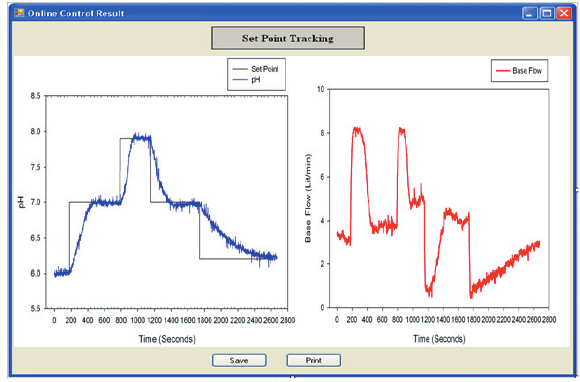
Figure 14: Set point tracking of pH neutralization process (Neural Network